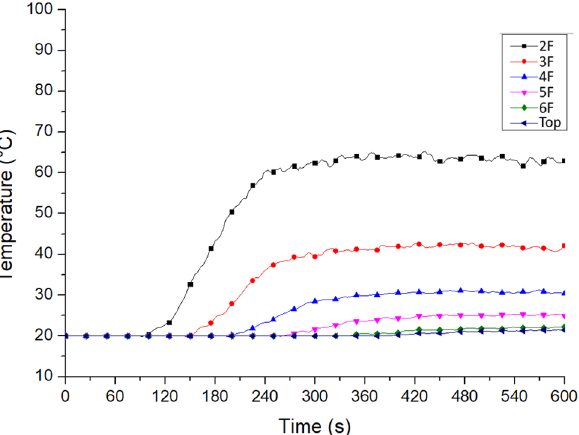
Figure 19. Temperature variation at the resident doors of No. 2 staircase on each floor (for Case Tc_WAc_B1o).